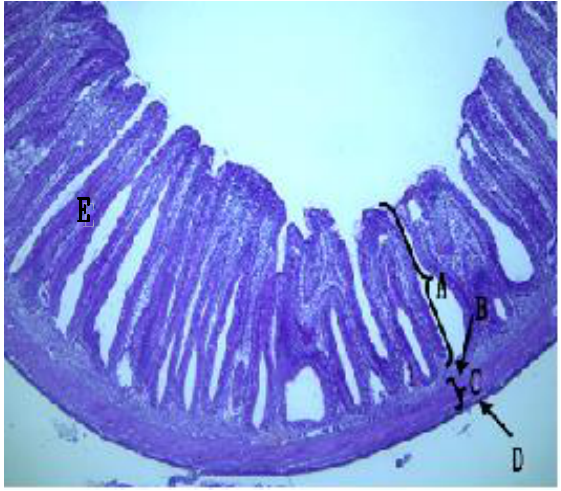
Figure, 4: Cross microscopic section of posterior portion of intestine of common carp, (A) mucosal fold, (B) goblet cell (arrow), (C) microvilli, PAS stain